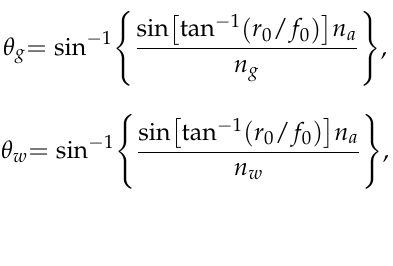
Figure 5. The coupling efficiency of the laser and waterjet.